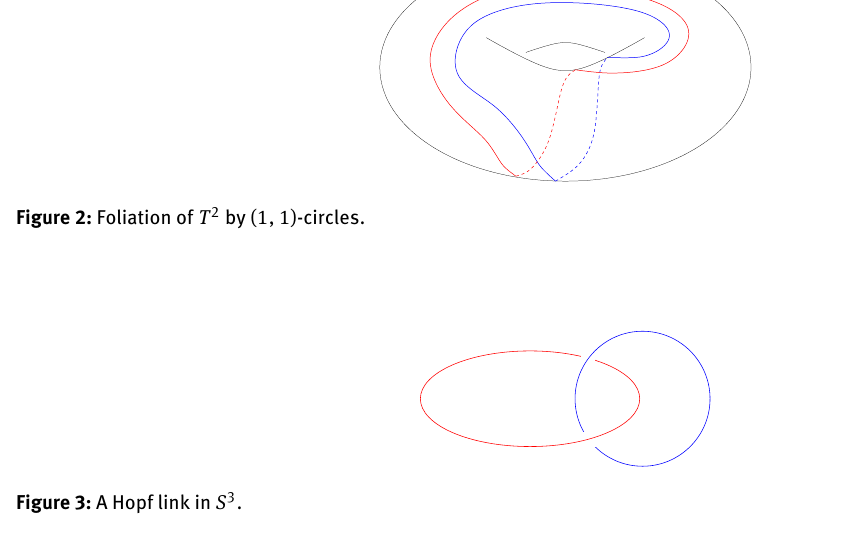
Figure 3: A Hopf link in S 3 .